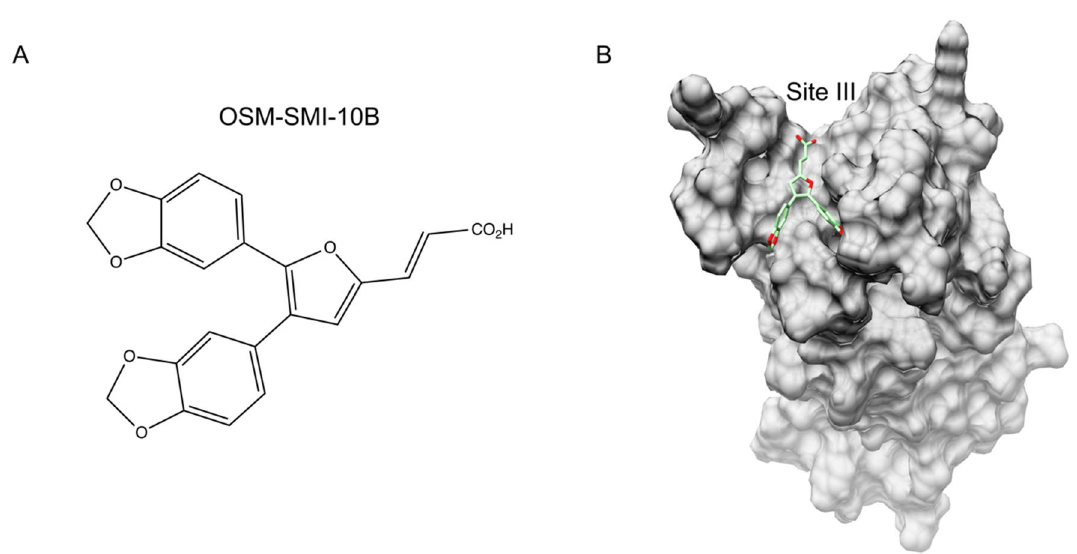
Figure 7. OSM-SMI-10B docked to OSM. ( A ) Chemical structure of OSM-SMI-10B. ( B ) OSM-SMI-10B (green and red) docked into a groove found at Site III on OSM (surface contour,